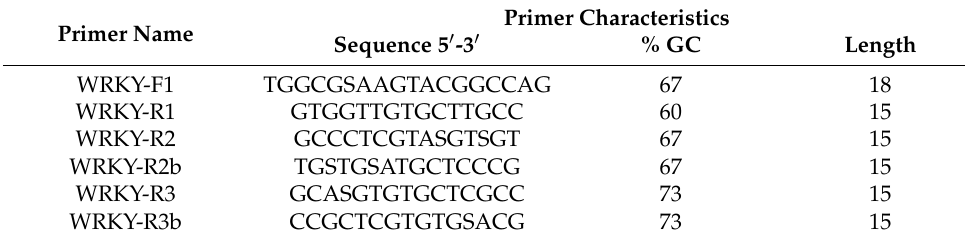
Table 4. Sequences of primers used in the study